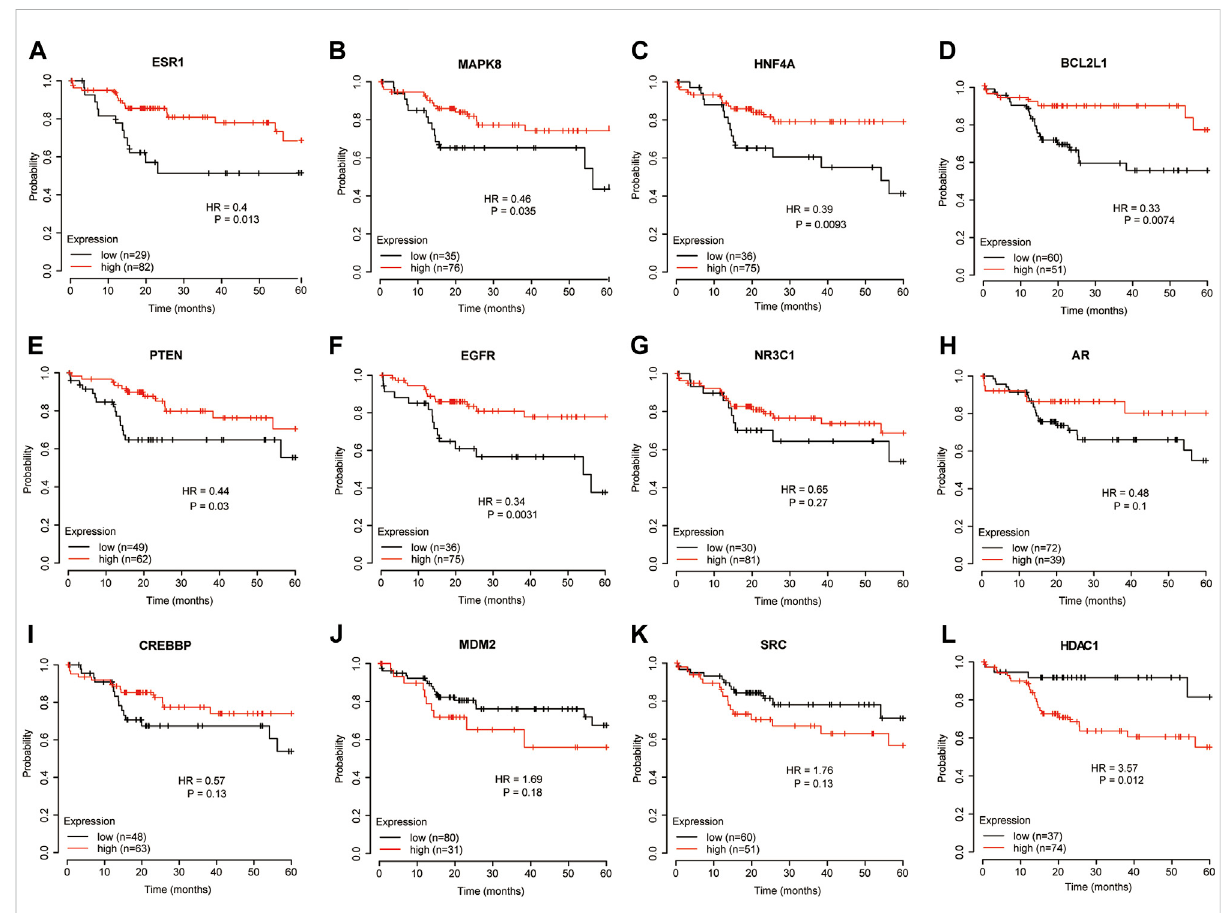
FIGURE 6 The survival prognostic analysis of the key genes in hepatitis-related HCC. (A) The overall survival analysis of ESR1. (B) The overall survival analysis of MAPK8. (C) The overall survival analysis of HNF4A. (D) The overall survival analysis of BCL2L1. (E) The overall survival analysis of PTEN. (F) TheoverallsurvivalanalysisofEGFR. (G) TheoverallsurvivalanalysisofNR3C1. (H) TheoverallsurvivalanalysisofAR. (I) Theoverallsurvivalanalysisof CREBBP. (J) The overall survival analysis of MDM2. (K) The overall survival analysis of SRC. (L) The overall survival analysis of HDAC1.The associationofthekeygenes ’ expressionintumortissuesandtheprognosisofhepatitis-relatedHCCpatients( n =111)inTCGAdatabase.Survivalwas calculated using Kaplan-Meier ’ s method and compared using log-rank